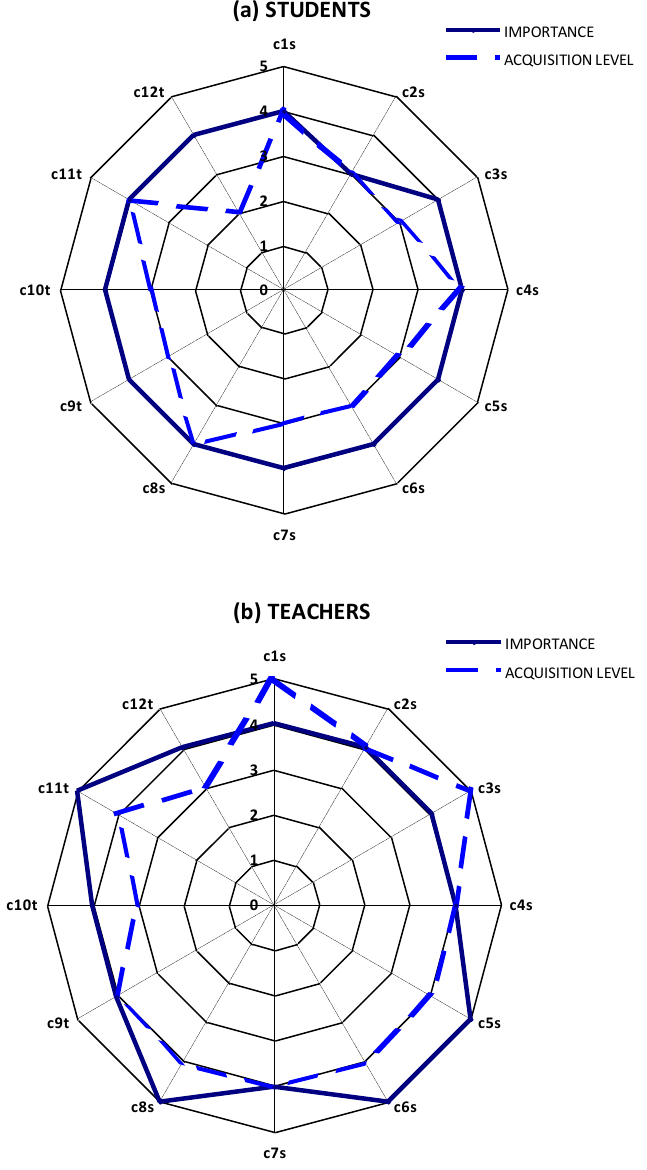
Fig 4. Results of skills evaluation procedure of Chemical Reactors (a) Students (b)